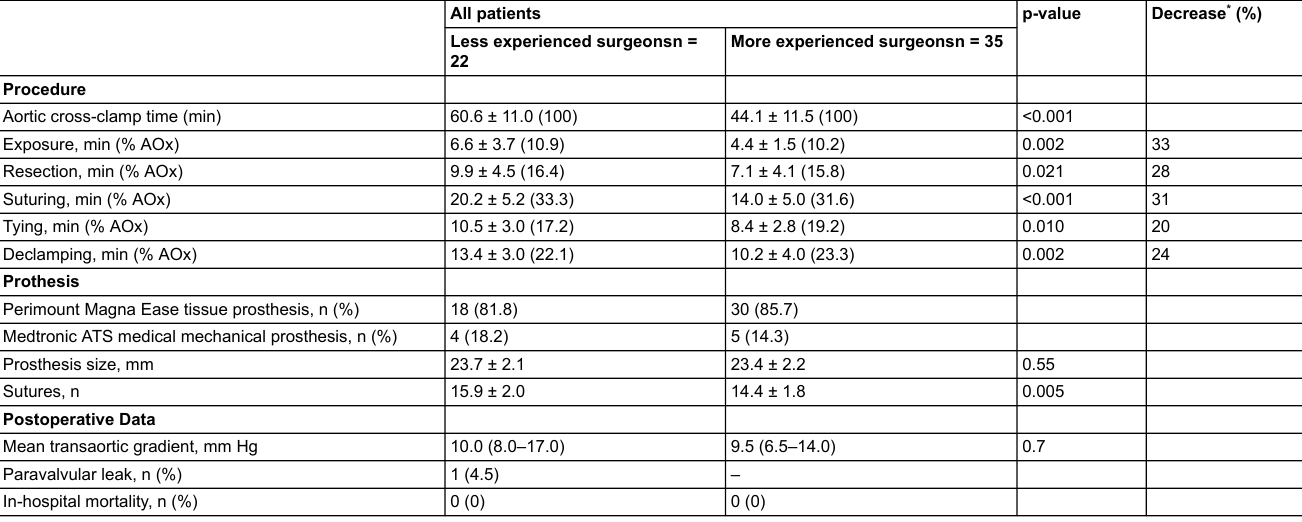
Table 2: Procedural characteristics and outcomes.